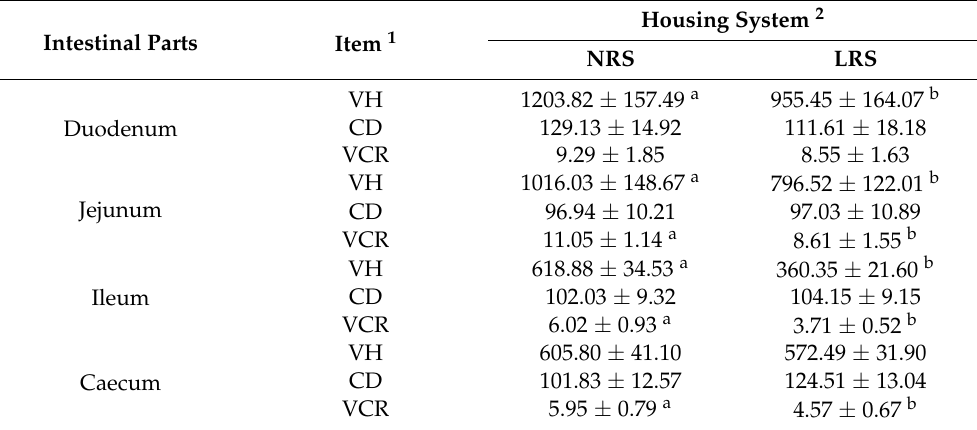
Table 3. Effects of two housing systems on morphological parameters of the intestine in hens from 32 to 40 weeks of